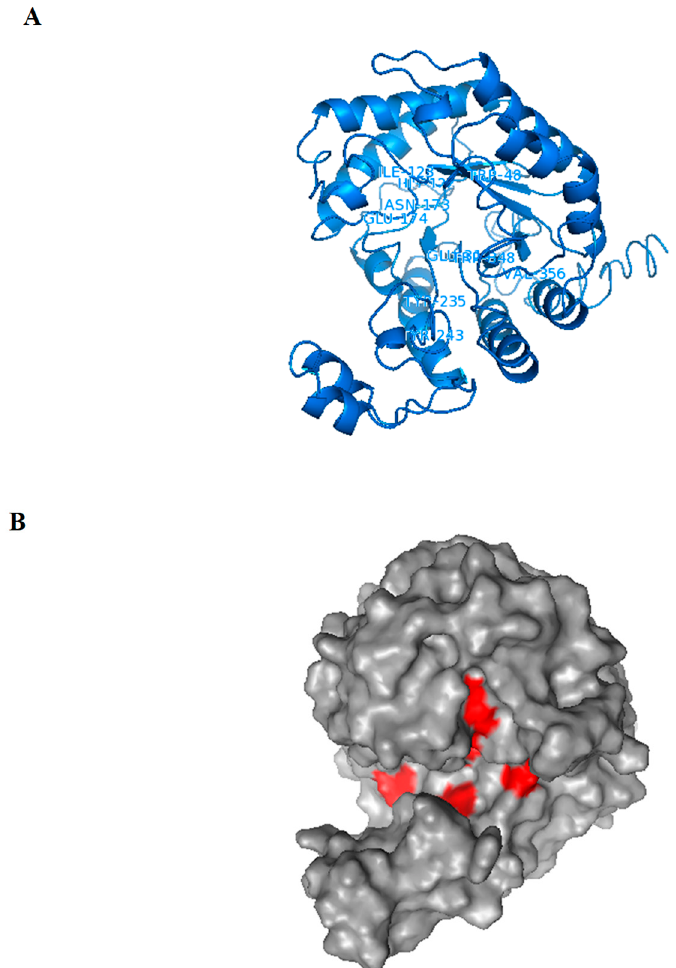
Figure 5. The Exg-D 3D structure model generated using I-TASSER. The structure formed a TIM barrel ( β / α ) 8 , which is a classical structural for enzymes found in GH family 5 ( A ). The amino acid resides found in the active site (which are predicted to interact with the ligands) are labelled in the cartoon 3D structure ( A ). The surface of the modelled structure shows that Exg-D’s active site forms a tunnel-like-cleft and the positions of amino acids residues which are predicted to interact with the ligands are indicated in red ( B ). The Exg-D modelled structure was visualised and labelled using PyMol.